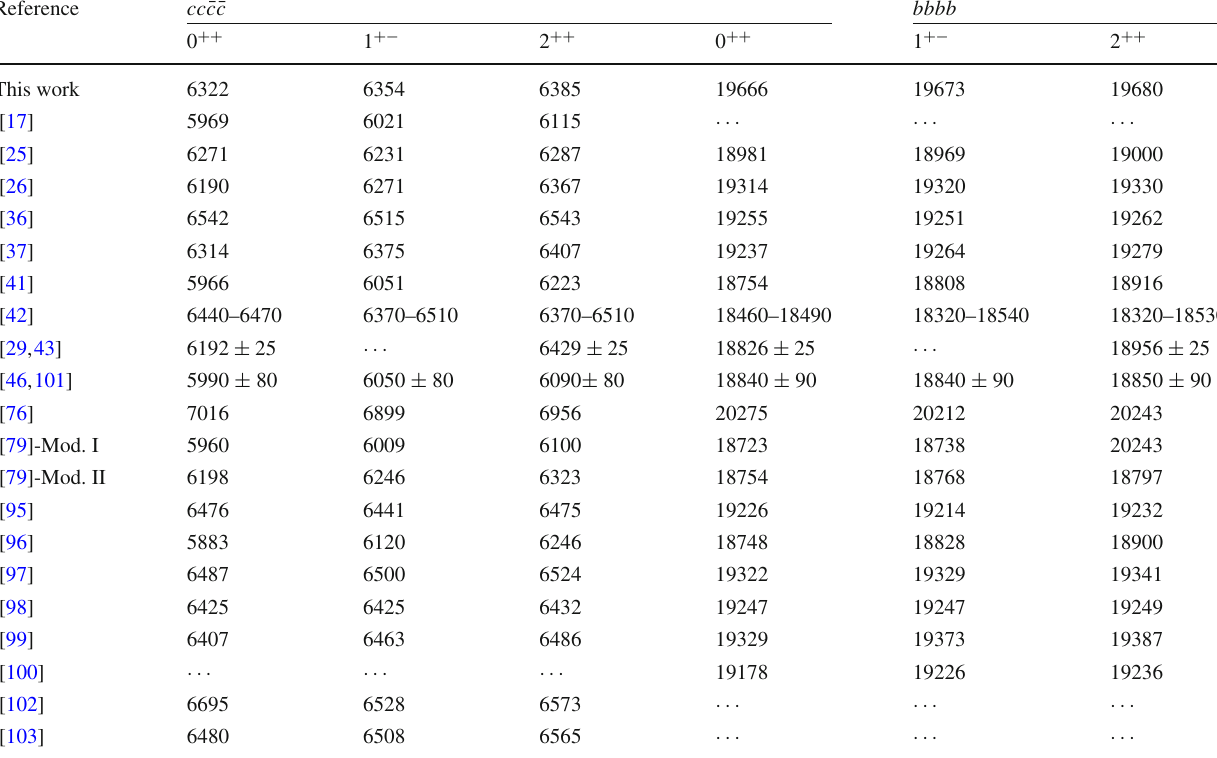
Table 9 Comparison of theoretical predictions for the ground state masses of the cc ¯ c ¯ c and bb ¯ b ¯ b tetraquarks. All results are in MeV